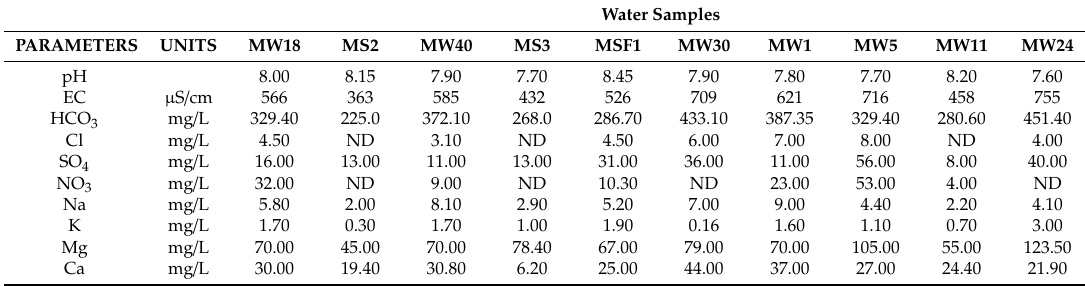
Figure 2. Classification of water samples at the hydrochemical graphs of the Durov diagram. Table 1. Physico-chemical characteristics of water samples. W indicate wells sample while S indicate springs. Water